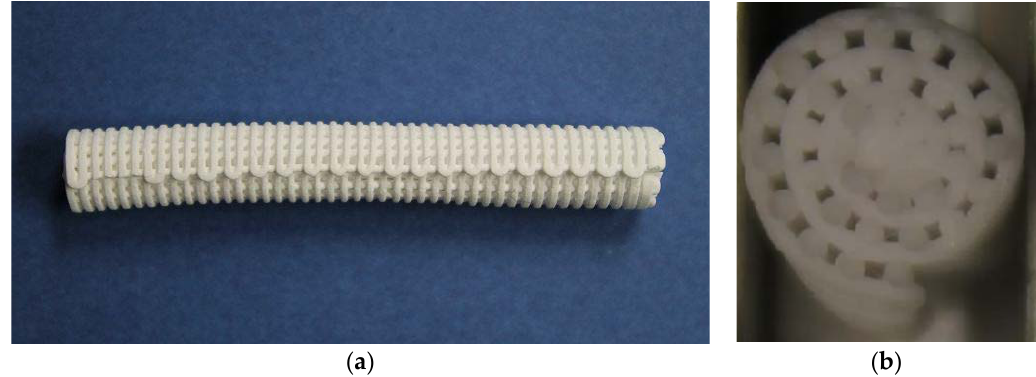
Figure 4. Thin 3D printed mesh of the study once rolled into a bone spacer cylinder shape: ( a ) side view—rolled, in green; ( b ) top view—final part after heat treatments.